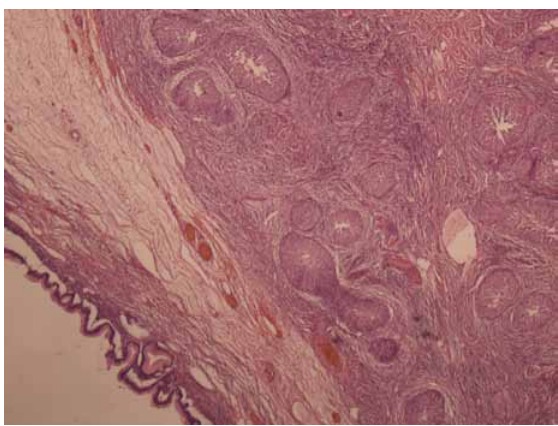
Figure 1. Association between mucinous cystadenoma (left) and Brenner tumor (right) in the ovary (HE 40x).